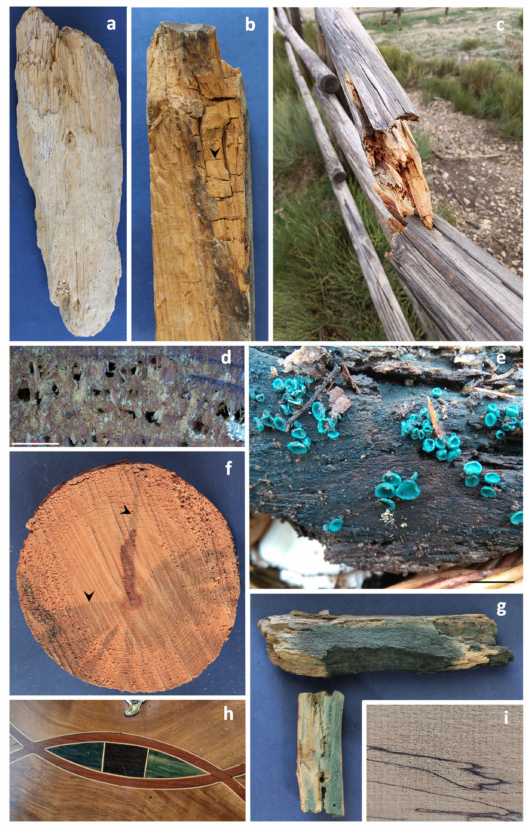
Figure 1. Wood deterioration caused by fungi. ( a ) Piece of wood with fibrillary appearance characteristic of white rot. ( b ) Piece of wood attacked by brown-rot fungi. Note that some cracks are formed in longitudinal and transverse planes, forming cubic-like shapes (arrowhead). ( c ) Wood railing heavily deteriorated by the action of brown-rot fungi. ( d ) Detail of the cross-section of a piece of Pinus sylvestris wood attacked by white pocket rot caused by Phellinus pini . Scale bar = 5 mm. ( e ) Fagus sylvatica wood showing fruiting bodies of Chlorociboria sp., which provides wood with a striking green colour, as can be observed in ( g ). Bar = 5 mm. ( f ) Cross-section of a pine trunk attacked by blue-stain fungi, which extend mainly in radial direction (arrowheads). ( h ) Wooden artwork in which green-stained wood by Chlorociboria sp. was used as decorative element (Urbino Ducal Palace, Italy). ( i ) Demarcation lines produced by fungi in